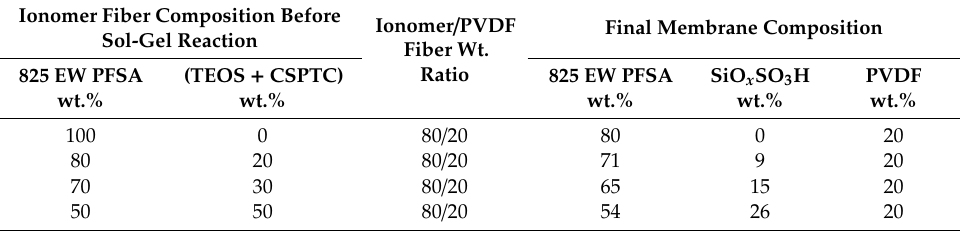
Table 2. Compositions of electrospun raw nanofiber mats and final membranes (after completion of the sol-gel condensation reaction).